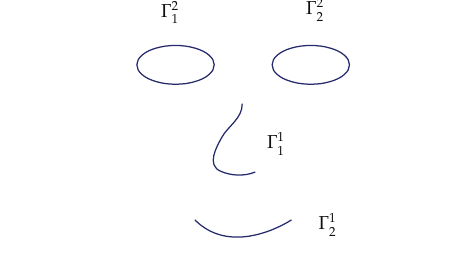
Figure 1: An example of an exterior